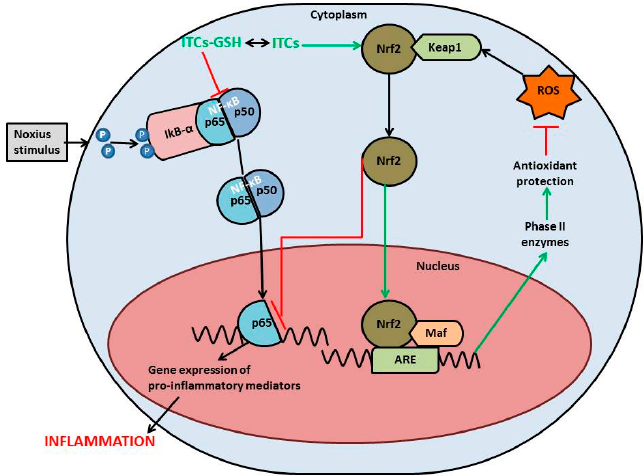
Figure 1. Summary of the main mechanisms involved in the neuroprotective activity of isothiocyanates (ITCs). ITCs are known not only to be potent NrF2 activators and to exhibit antioxidant effects via the upregulation of ARE ‐ driven genes, but also to decrease the inflammatory response through the NF κ B pathway. Red arrows: blocked pathways; green arrows: enhanced pathways; black arrows: normal pathway of NF κ B.